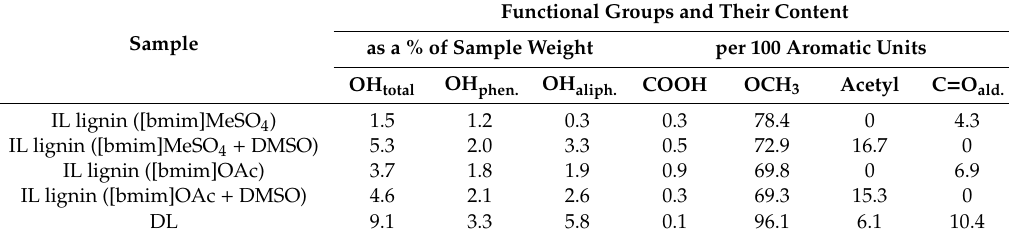
Table 2. Functional composition of isolated IL lignins and dioxane lignin determined by 31 P and 13 C-NMR